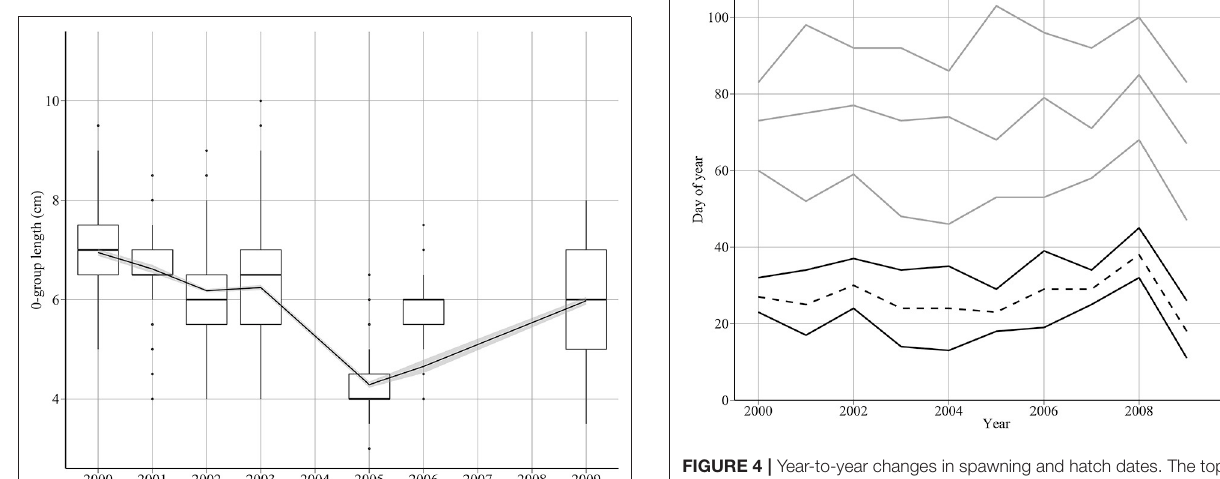
FIGURE 4 | Year-to-year changes in spawning and hatch dates. The top three lines show median hatch date (dotted grey line) enclosed by hatch start and end dates (dashed and solid grey lines, respectively). The bottom two solid lines show the estimated spawning interval derived by backtracking from hatch dates. The bottom dashed line shows the estimated mean spawning